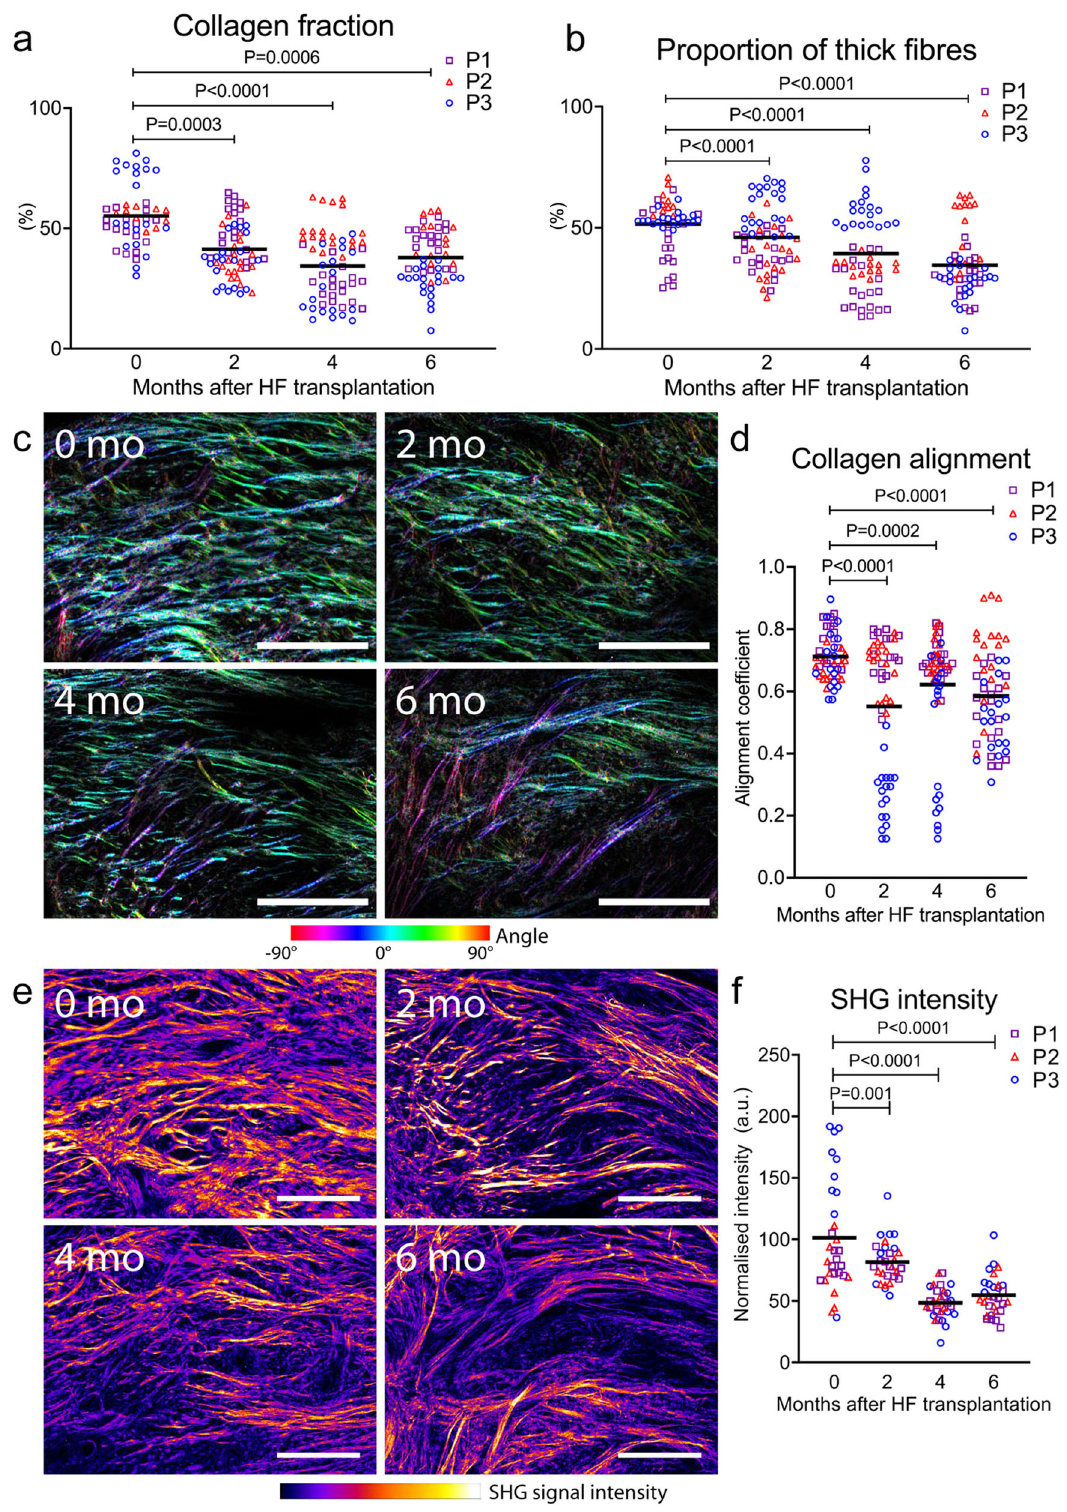
Fig. 4 Anagen hair follicles remodel the architecture of COLI in mature scars. a Analysis of second harmonic generation (SHG) images reveals a decrease in the total fraction of collagen type I (COLI) fi bres and ( b ) proportion of thick fi bres at 2, 4, and 6 months after hair follicle (HF) transplantation into mature scars ( n = 36, N = 3). ( c ) Colour-coded maps of fi bre orientation show preferential alignment of fi bres along the epidermis (0° angle) before hair transplantation. ( d ) At 2 months post-transplant, collagen fi bres become more disorganized as the alignment coef fi cient decreases ( n = 18, N = 3). e The SHG signal intensity can be used as a proxy measurement for tension in collagen fi bres. f We found that the SHG signal intensity decreases at 2 months after hair follicle transplantation and remains low throughout the follow-up period ( n = 20, N = 3). Reported P values are based on two ‑ way ANOVA tests, and the horizontal lines show grand means. Representative images from one patient, scale bars = 200